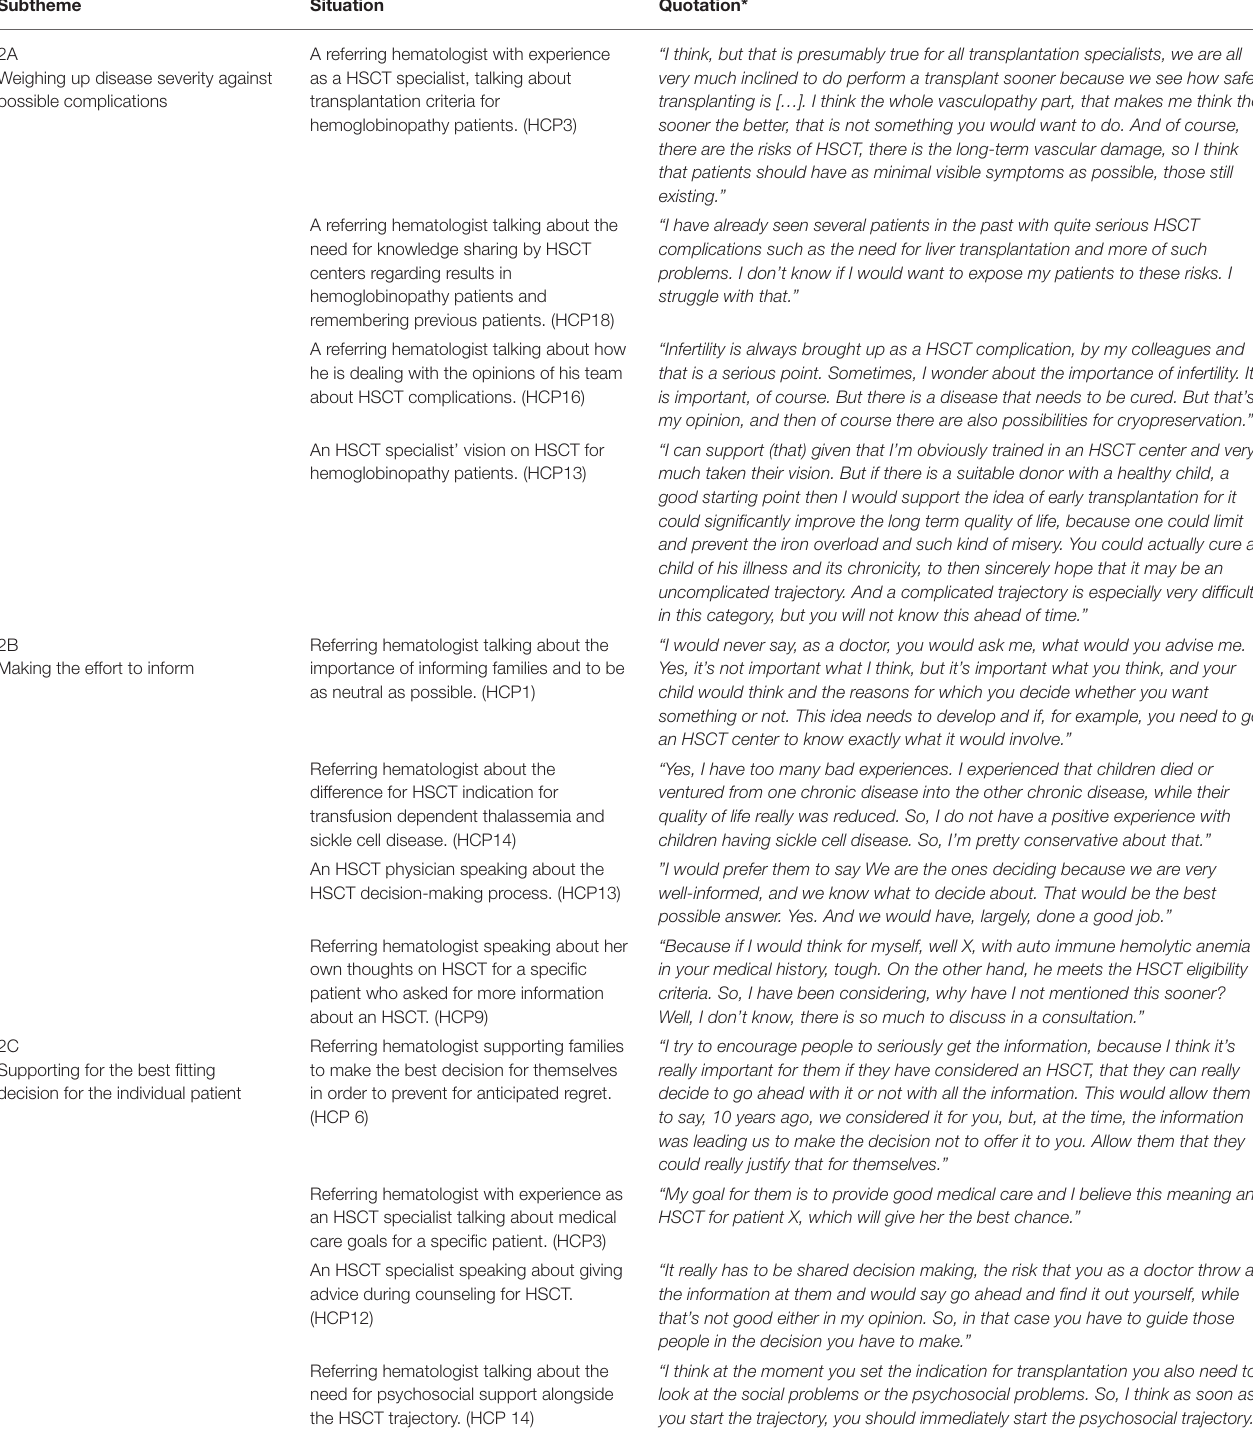
TABLE 3 | Illustrative